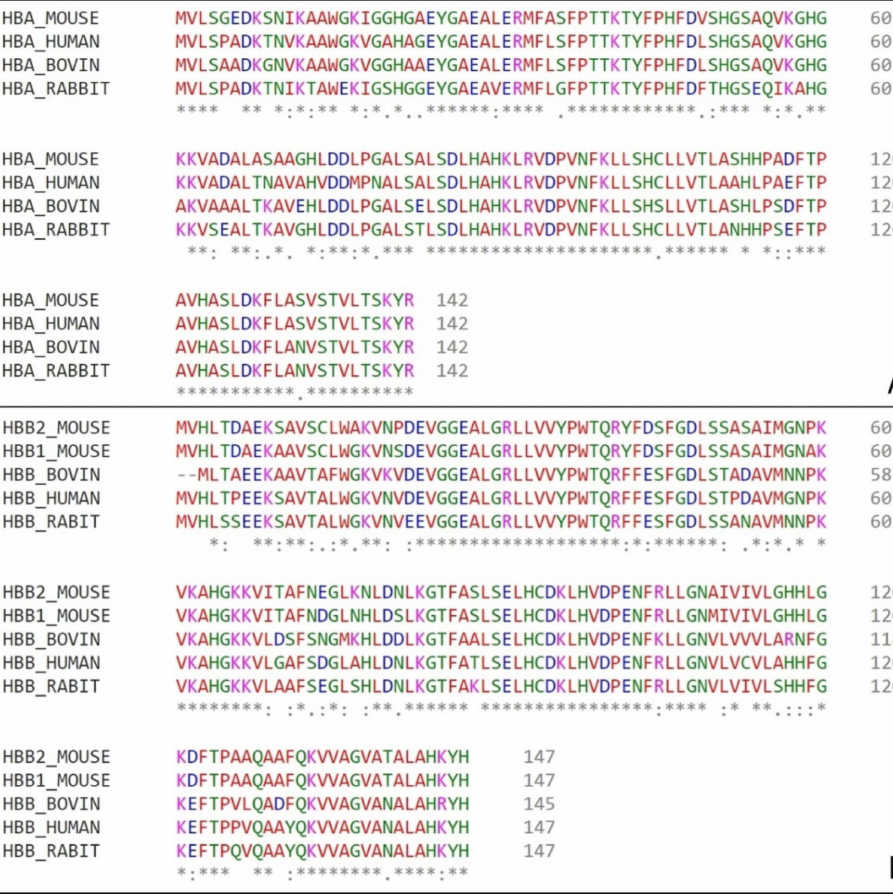
Figure 5. Hemoglobin sequences alignment. ( A ) Alpha chains amino acid comparison from mouse ( Mus musculus) tag HBA_MOUSE, bovine ( Bos Taurus ) tag HBA_BOVINE, human ( Homo sapiens ) tag HBA_HUMAN and rabbit ( Oryctolagus cuniculus ) tag HBA_RABBIT. ( B ) Beta chains amino acid comparison from mouse ( Mus musculus) tags HBB1_MOUSE and HBB2_MOUSE for β 1 chain and β 2 chain respectively, bovine ( Bos Taurus ) tag HBB_BOVINE, human ( Homo sapiens ) tag HBB_HUMAN and rabbit ( Oryctolagus cuniculus ) tag HBB_RABBIT. (*) – position with a single and fully conserved amino acid residue; (:) – position with amino acid residues conserved between groups of strong similar properties; (.) – position with amino acid residues conserved between groups of weakly similar